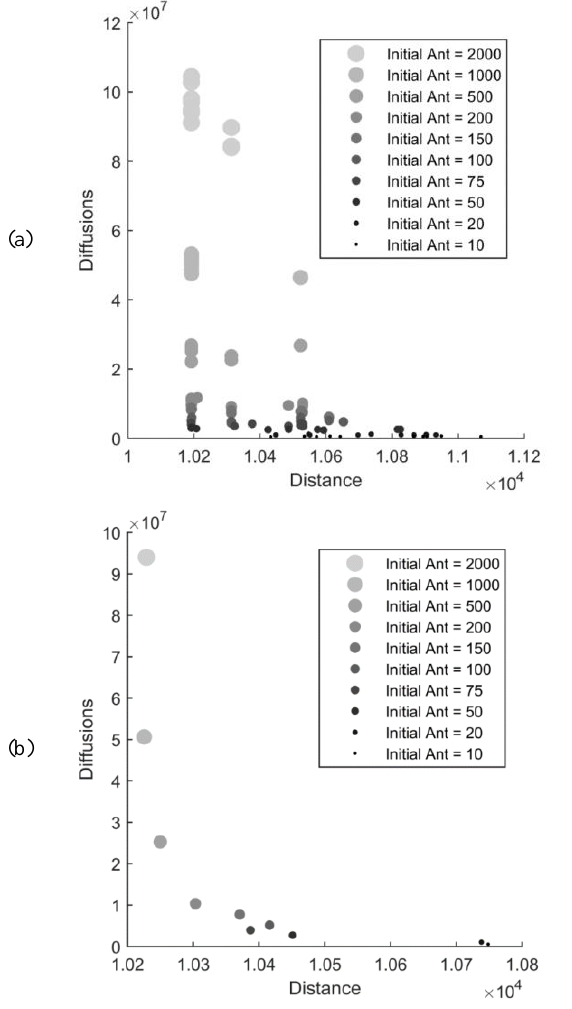
Figure 7. (a) The results of all 200 practices. (b) Average of all 20 practices of each variant of the